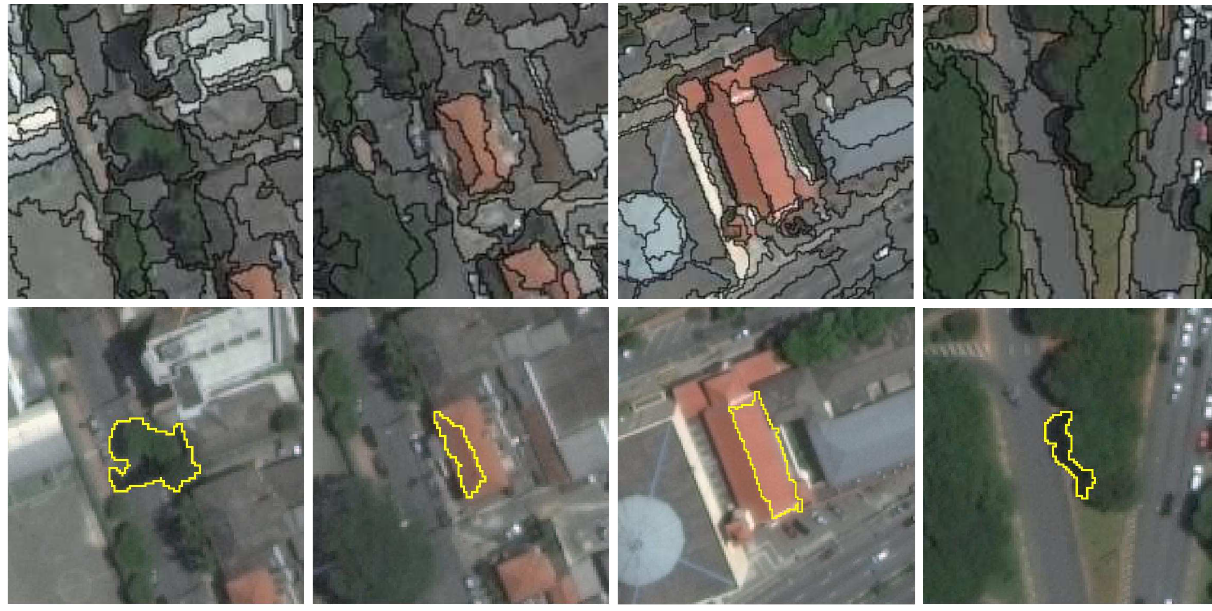
Comparison of traditional ( top ) and focused ( bottom ) methods for showing